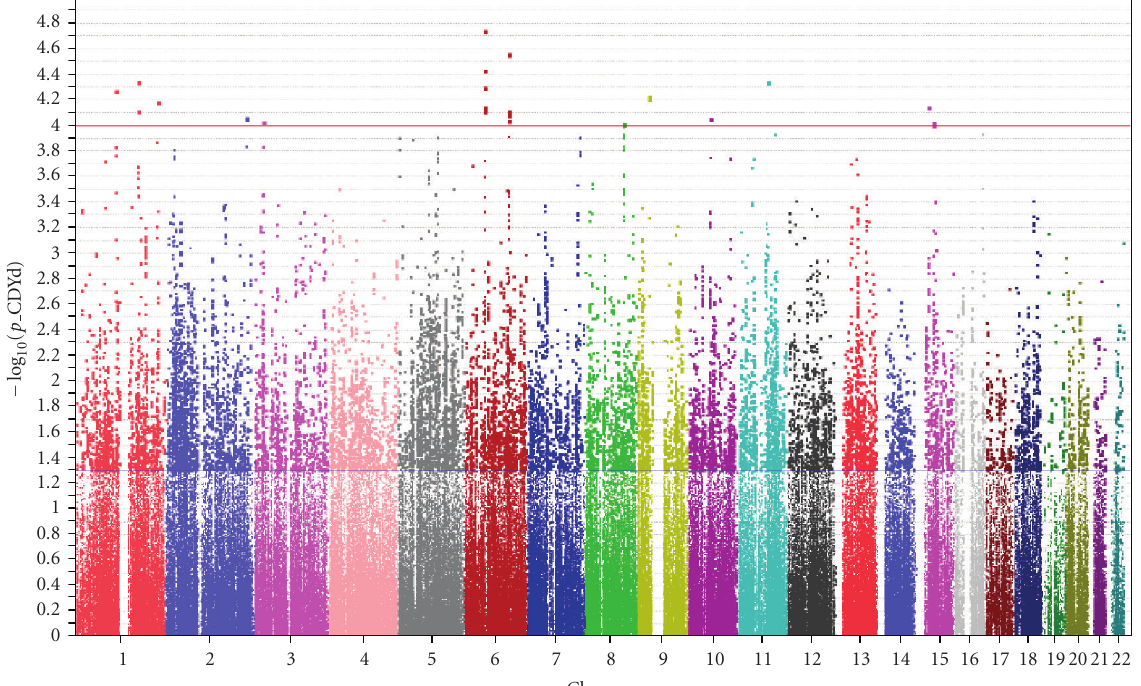
Figure 2: Summary of genome-wide associations between 421,010 well-imputed SNPs and severe diabetic retinopathy under additive genetic model adjusted for age, gender, diabetes duration, and HbA1c